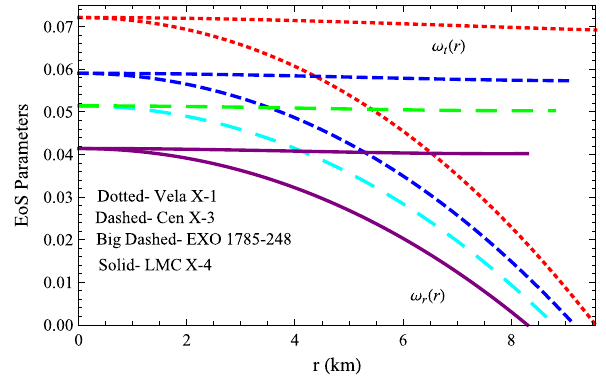
Fig. 4 Radial EoS parameter and transverse EoS parameter vs the radialcoordinate r correspondingtonumericalvaluesofconstantsgiven in Table 2 for four well-known compact stars